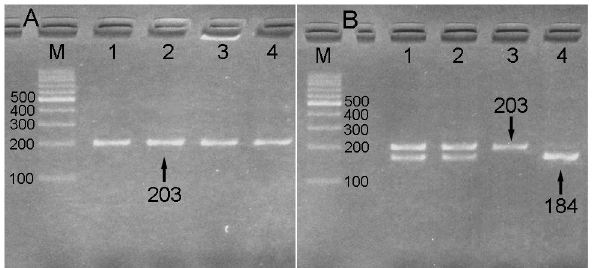
Figure 1. Electrophoresis of PCR products of the samples and genotyping of the IL -8 +781C/T SNP. (A) IL -8 +781C/T SNP: lane M, 100 bp marker ladder, lanes 1–4, samples, the 203 bp bands are the PCR products. (B) genotyping of the IL -8 +781C/T SNP: lane M, 100 bp marker ladder; lanes 1 and 2, CT genotype (203-, 189- and 19-bp); lanes 3, TT genotype (203 bp); and lanes 4, CC genotype (184- and 19-bp). The 19 bp fragment was invisible in the gel owing to its fast migration speed.